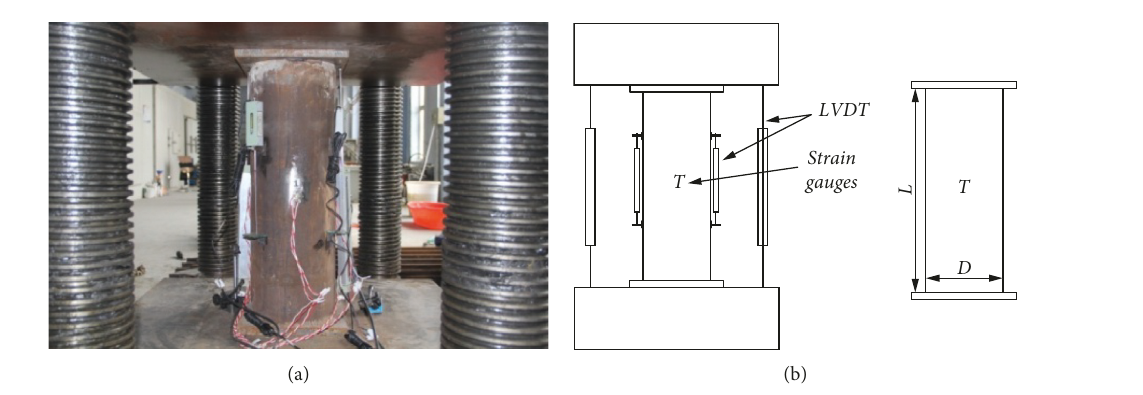
Figure 2: Test setup and instrumentation of stub columns.